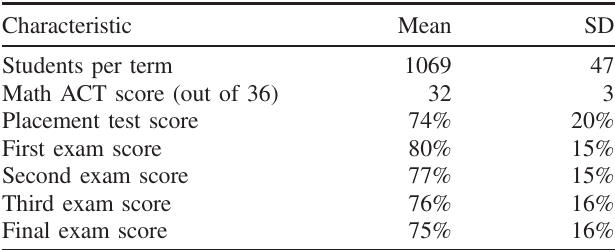
TABLE I. Means and standard deviations (SD) of enrollment numbers and student test